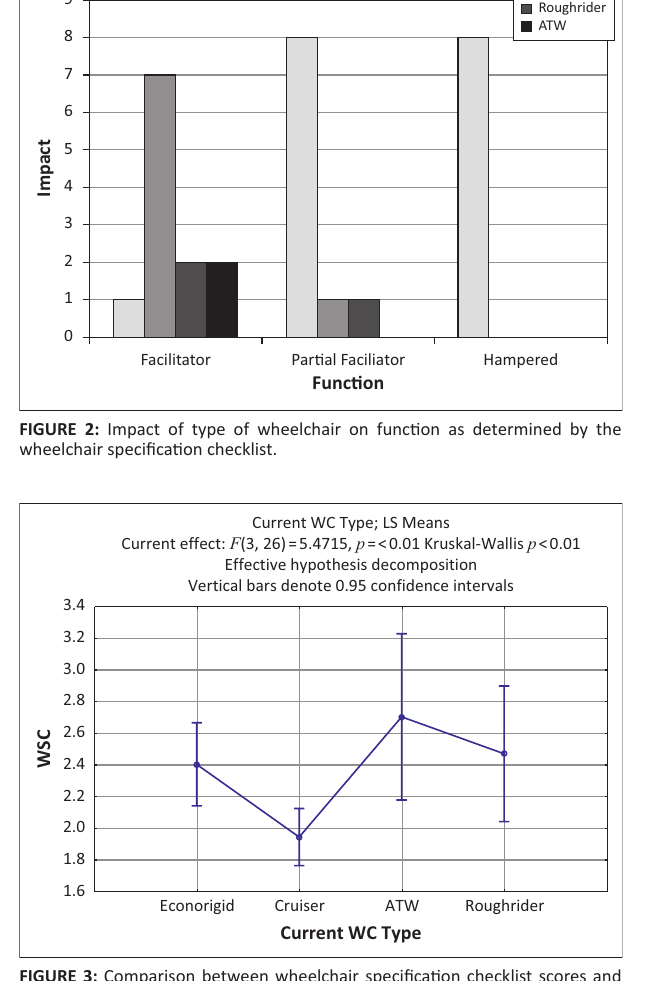
FIGURE 3: Comparison between wheelchair specification checklist scores and wheelchair design (Kruskal-Wallis; p =